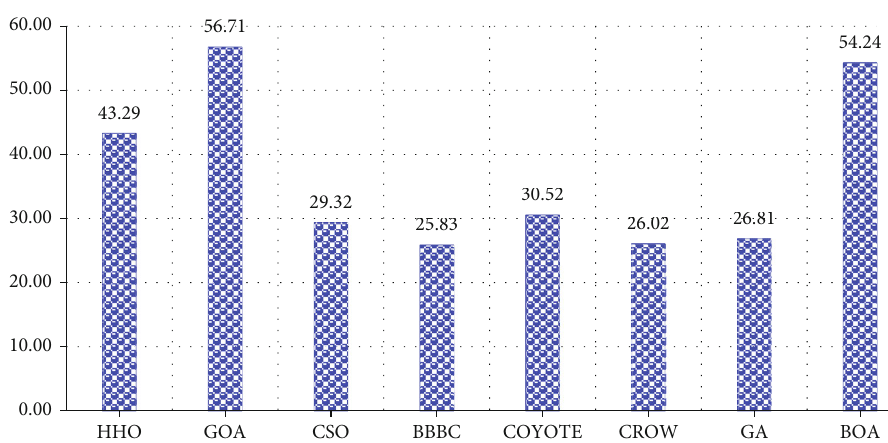
Figure 8: The computational time of the eight metaheuristic algorithms under